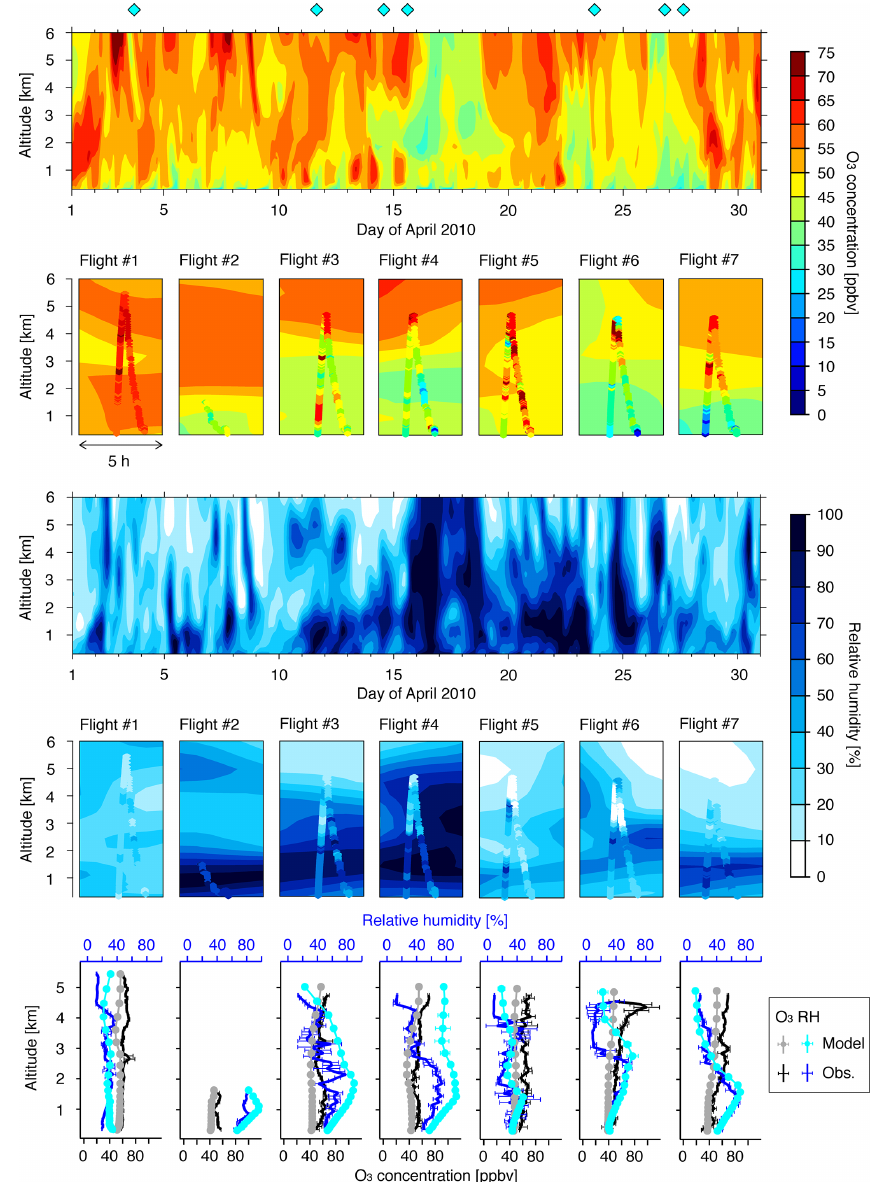
Figure 6. Curtain plot and vertical profiles of O 3 and RH at the aircraft observational site: Southern Great Plains, Oklahoma. Gray diamonds indicate the times of the seven aircraft flights, and results for these flights are shown in the expanded boxes for 5h time windows overlaid with observations. Observed ascent and descent profile data are averaged into 100m grid resolution, and profiles of the mean and standard deviations are shown. Modeled ascent and descent data corresponding to the observation times are averaged on original modeled layers, and the mean and standard deviations are